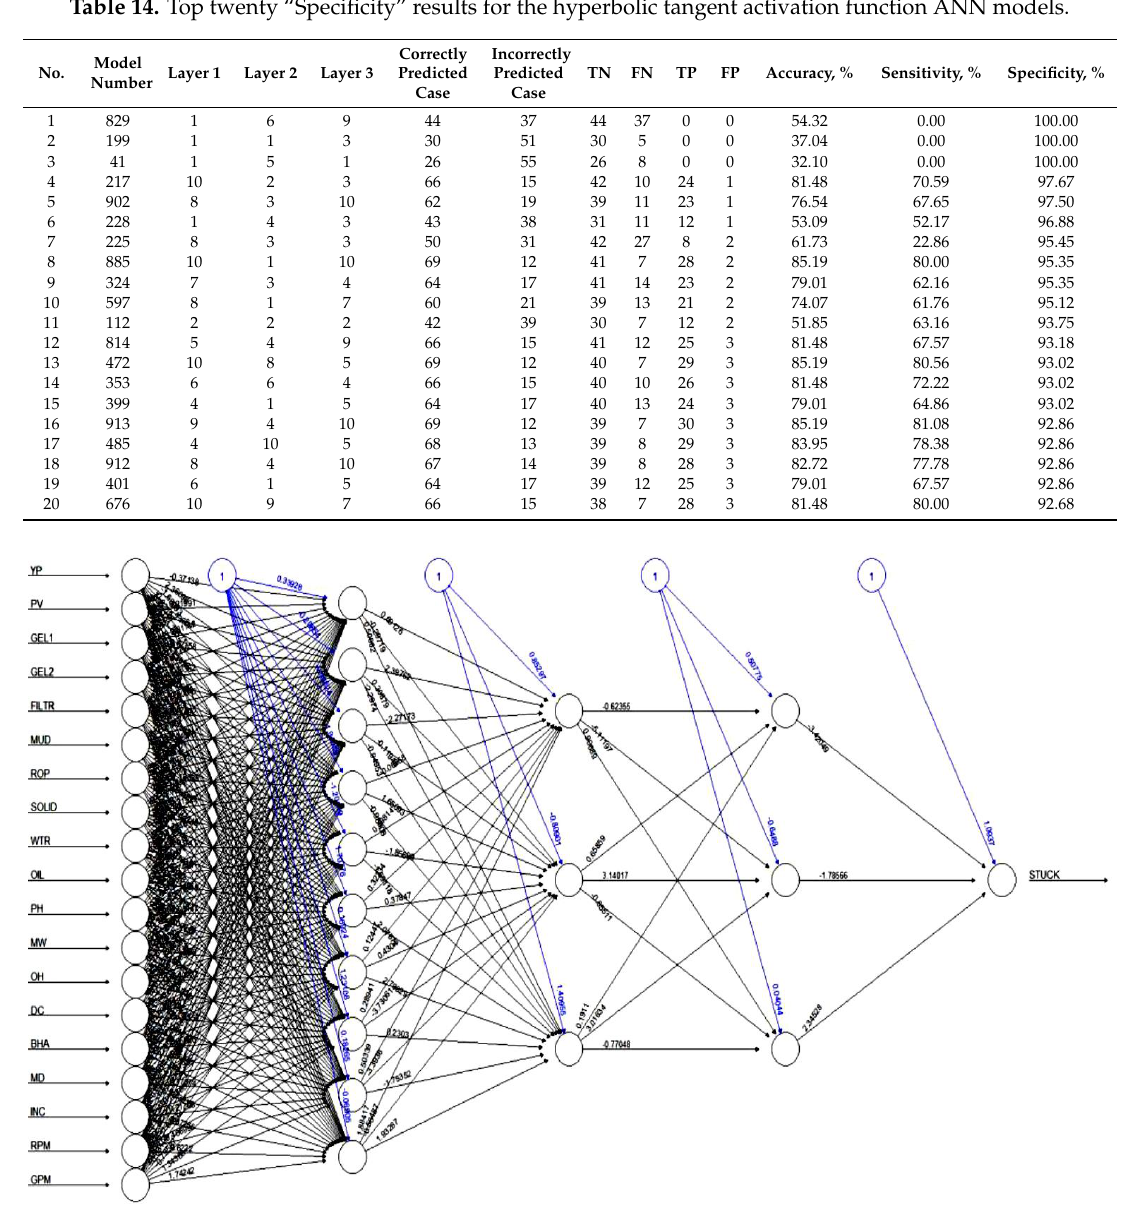
Figure 7. Topology [19, 10, 3, 3, 1] of the best ANN model using the hyperbolic tangent function (model no. 227). Table 15. Summary of best ANN models of logistic and hyperbolic tangent activation